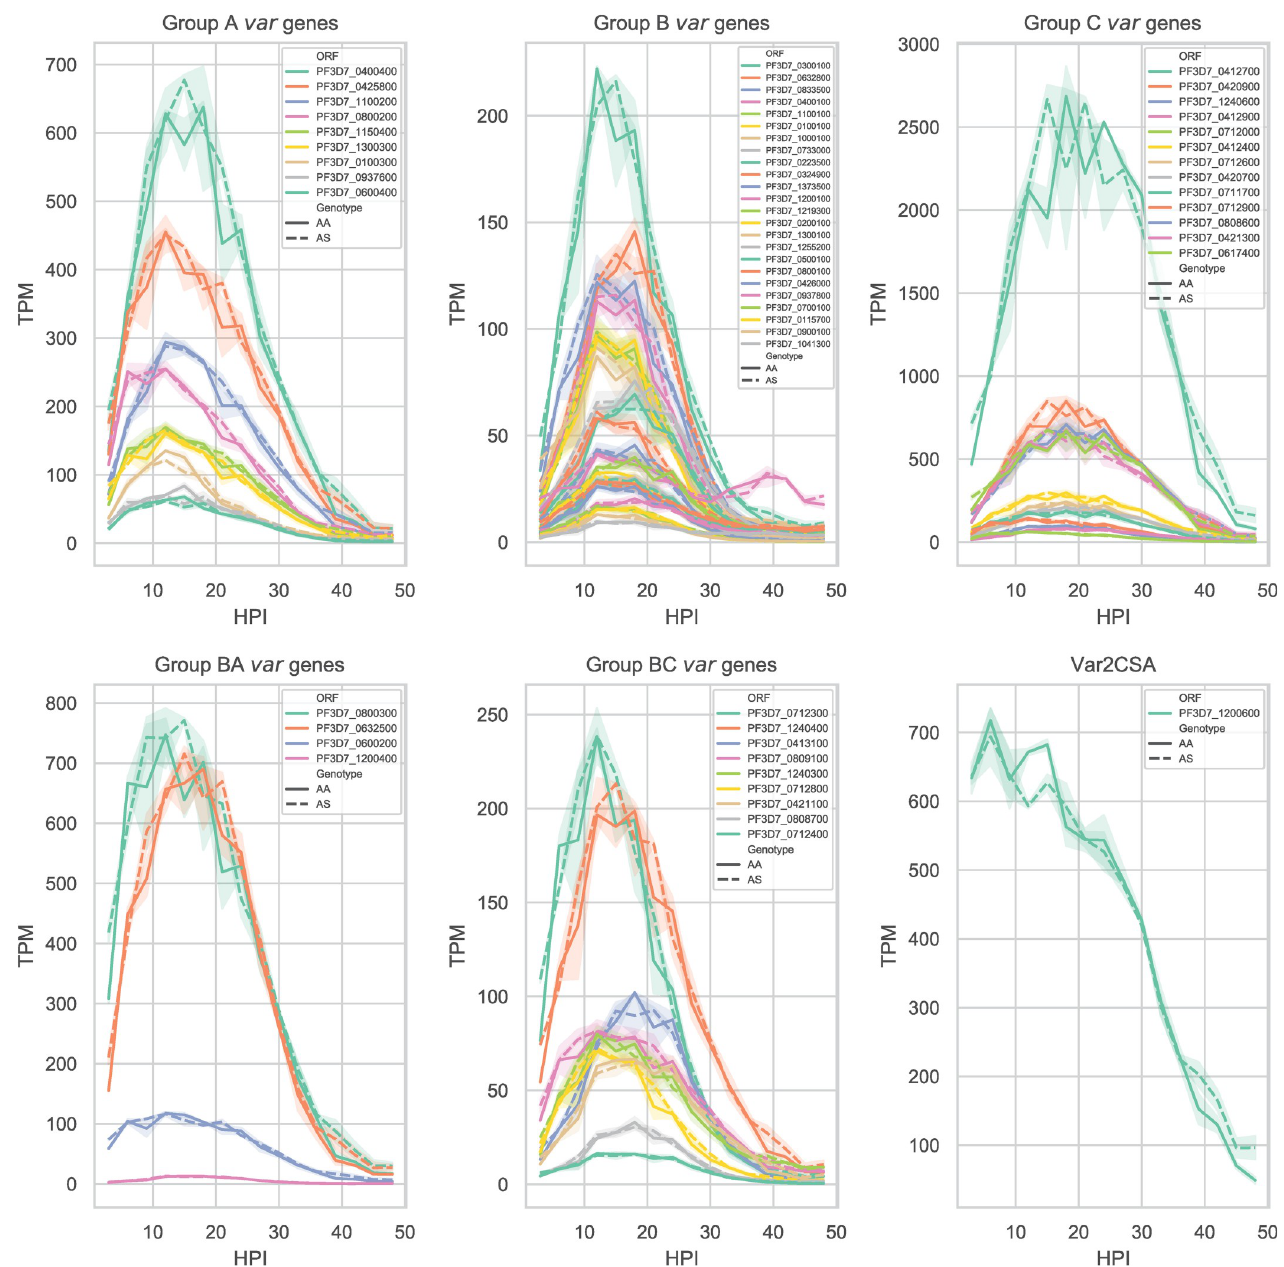
Fig 1. 3D7 var gene expression across the asexual stage in blood from HbAA and HbAS donors. Var gene transcription relative to total RNA transcripts per million (TPM), every three hours post invasion (HPI) for 48 hours. Var genes are grouped according to their UPS classification, and individual var genes are represented by different colors according to their open reading frame (ORF). Solid lines represent average transcription of two HbAA donors, and dashed lines the average transcription of two HbAS cultures, and shaded areas are the min and max replicate value. Note difference in y-axis scales between panels. https://doi.org/10.1371/journal.ppat.1009659.g001 (2.9 μ g/ml) and HbAS (2.8 μ g/ml). In these models, the maximum adhesion of HbAA was 100.8 (6.1 Std. error) while HbAS was 26.8 (2.5 Std. error), corresponding to 73% lower maxi- mum adhesion to CD36 for HbAS iRBCs.